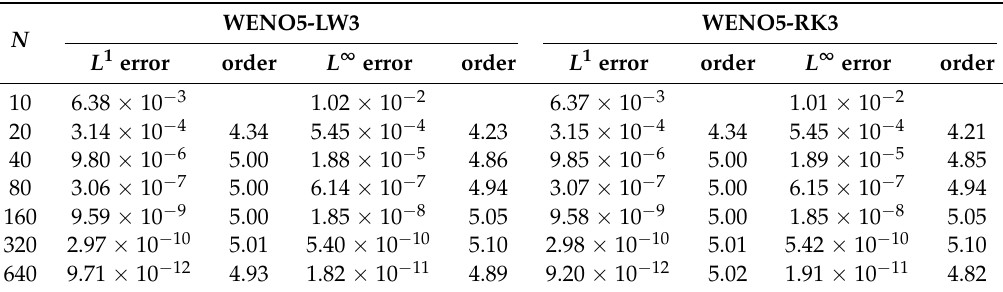
Table 1. L 1 and L ∞ errors and numerical orders of accuracy for density of one-dimensional order test, WENO5-LW3 and WENO5-RK3 using N space mesh points.